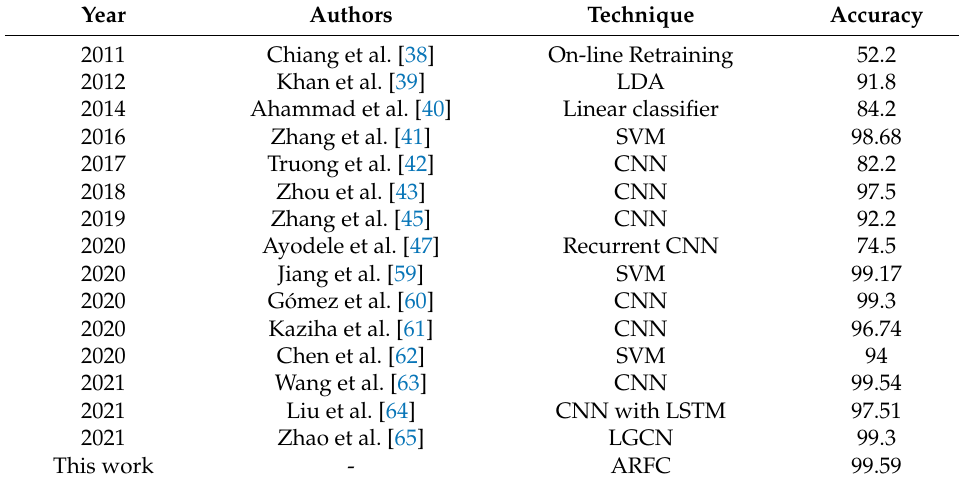
Table 7. The performance of ARFC compared to 15 related